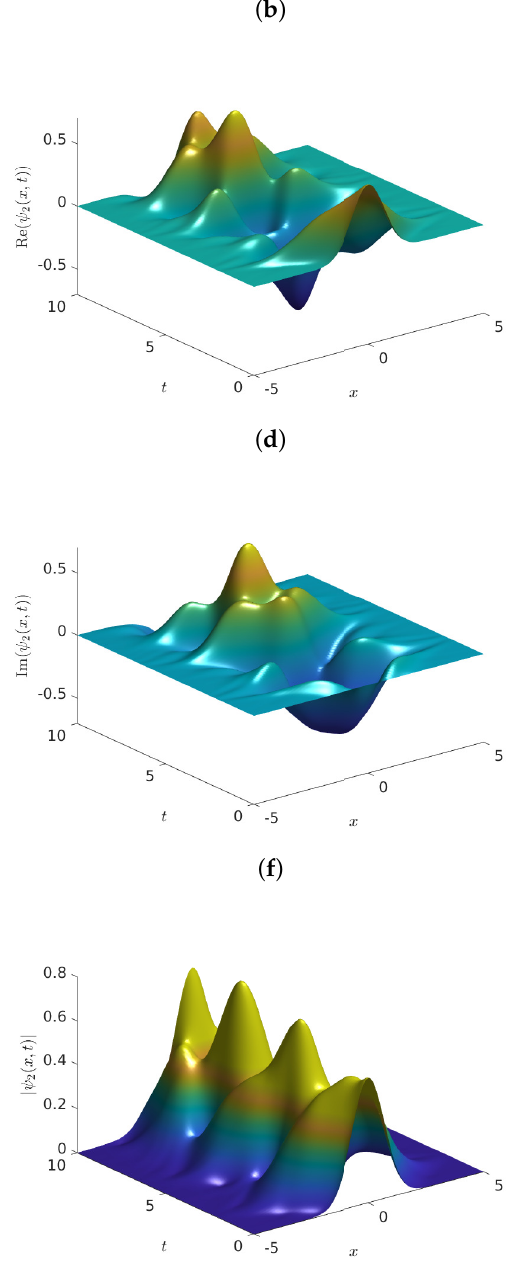
Figure 2. Approximate solutions for the problem (4) using the parameters in Table 1, and the computational time-steps h = 0.1 and τ = 0.05 for the finite-difference method (36). We used V ( x ) = 1 x 2 , and initial data φ 1 ( x ) = φ 2 ( x ) = 2 1 √ exp ( − x 2 ) . The graphs provide the behavior of ( a ) Re ψ 1 , ( b ) Re ψ 2 , ( c ) Im ψ 1 , ( d ) Im ψ 2 , ( e ) | ψ 1 | , and ( f ) | ψ 2 | , versus π ( x , t ) . In these simulations, we used α = 1.1 and α = 2 1